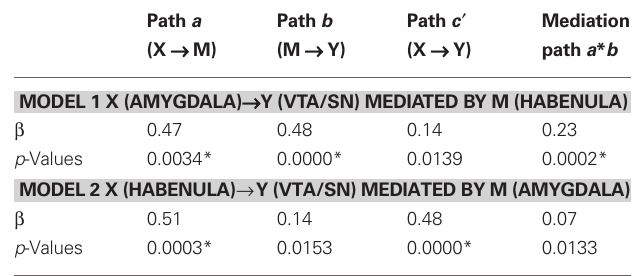
β denotes the regression coefficients and p-values are uncorrected. The mark “*” indicates significant connections at p < 0.05, Bonferroni corrected (p = 0.05/4 =